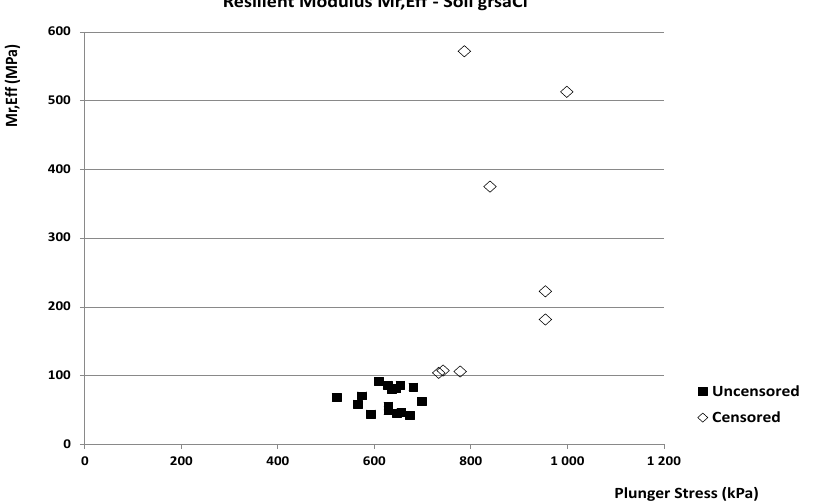
Figure 7. Resilient modulus M r,eff for soil sagrSi.